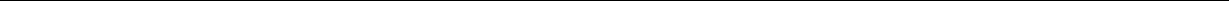
Flow cytometry . The skin on the back of the mice was shaved and wounds were harvested and incubated overnight at 4 (cid:2) C in 0.05% trypsin-EDTA (Invitrogen) for